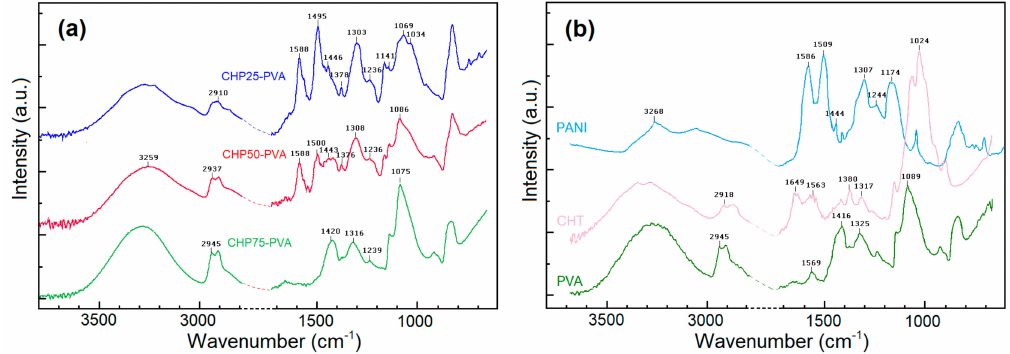
Figure 3. Normalized FTIR spectra: ( a ) ternary polymer composites with variable chitosan content; and ( b ) pristine components. The spectral region (1700–2800 cm − 1 ) was omitted for